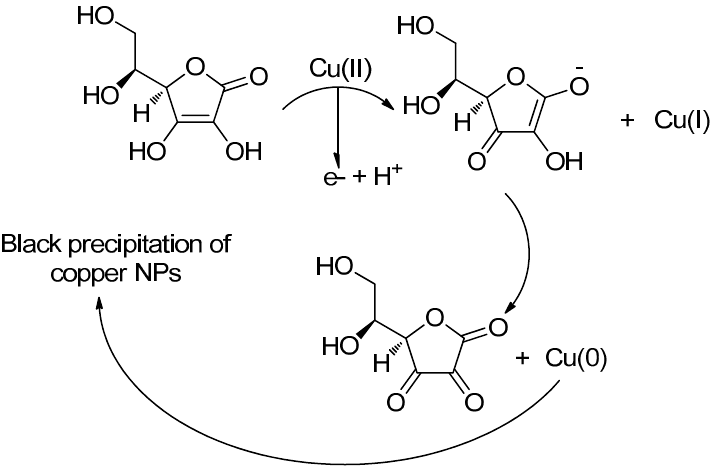
Scheme 17. Berberis vulgaris fruits extracted as an eco-synthesis of copper NPs.